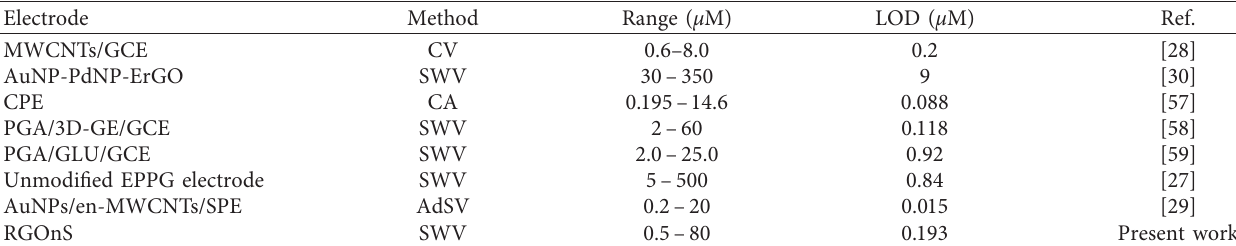
Table 1: Comparison of the data obtained using electrochemical methods for the determination of amoxicillin. Electrode Method